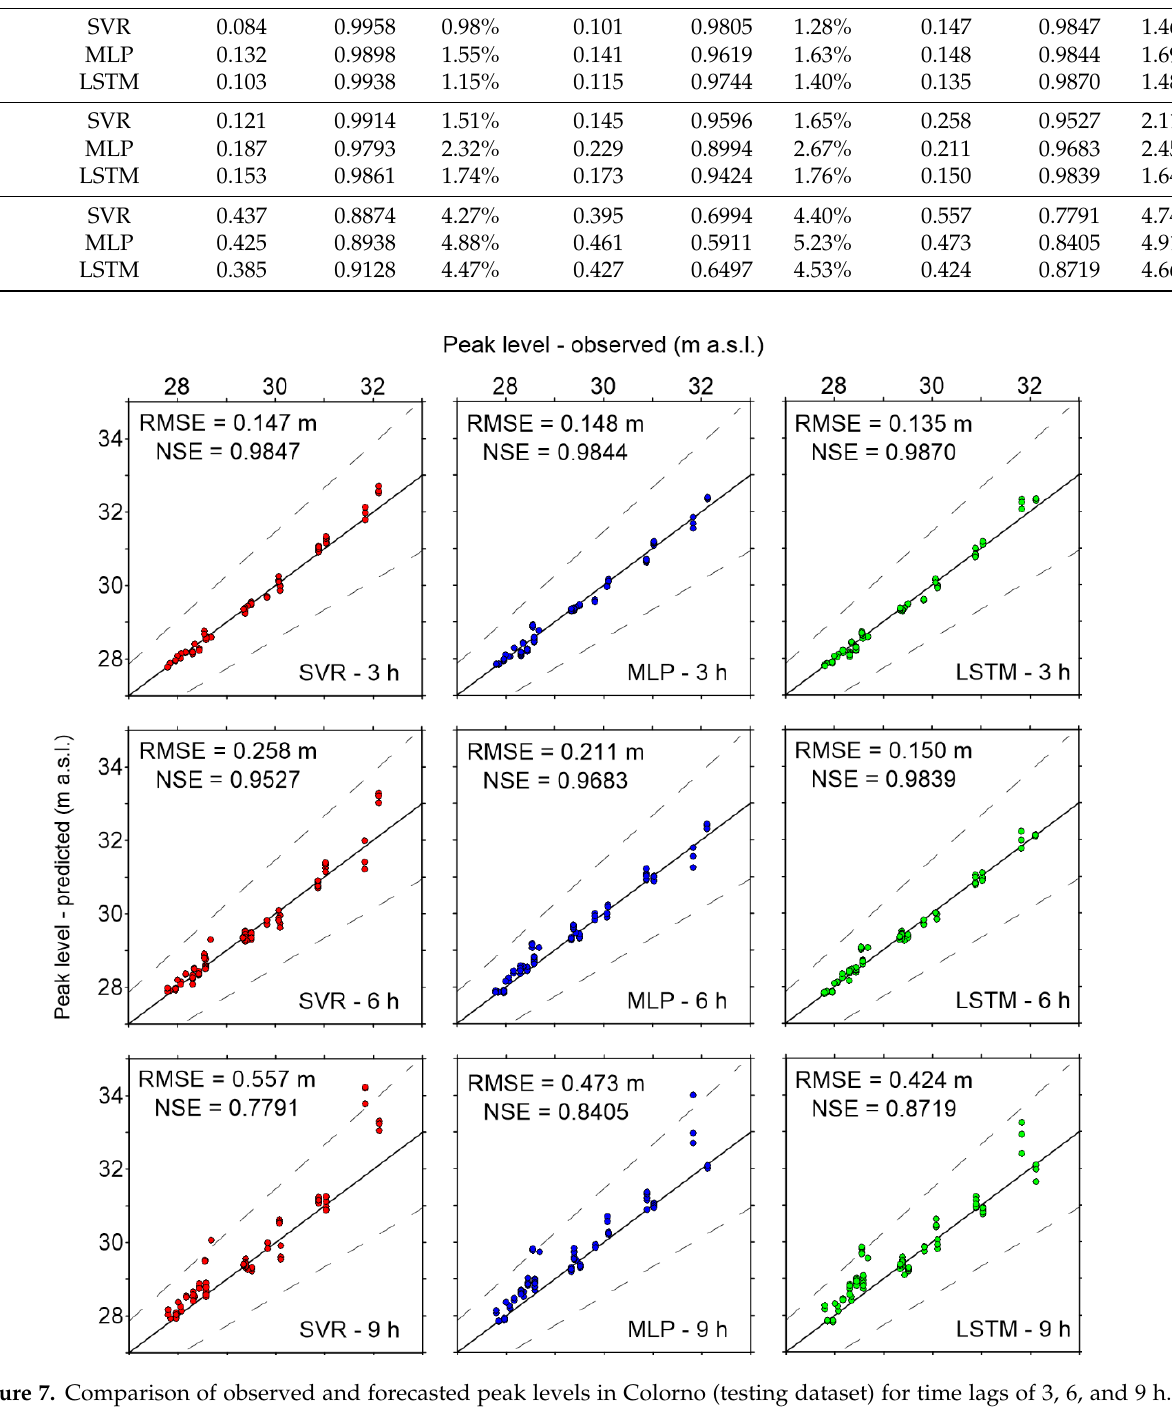
Table 4. Comparison of ML models’ performance in predicting peak levels for training, validation, and testing dataset. Training Time Lag Model Time Lag